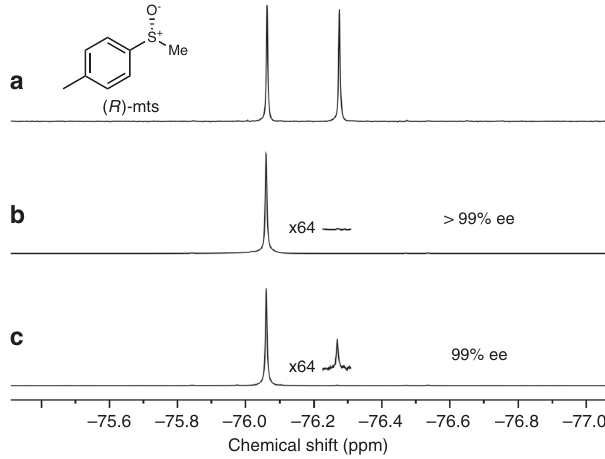
Fig. 5 Evaluation of enantiopurity and stability of ( S Zn )-[ZnL(NC t Bu)] by 19 F NMR spectroscopy (C 6 D 6 , 300 K, 471 MHz). a Structure of the chiral shift reagent ( R )-mts and the reference spectrum with rac -[Zn 2 L 2 ] + ( R )-mts (1.10 equiv.). b Isolated ( S Zn )-[Zn L (NC t Bu)] + ( R )-mts (5 equiv.). c ( S Zn )- [Zn L (NC t Bu)] was heated at 70°C in C 6 D 6 (8mM) for one week, then ( R )- mts (5 equiv.) was added to the reaction mixture. ee enantiomer